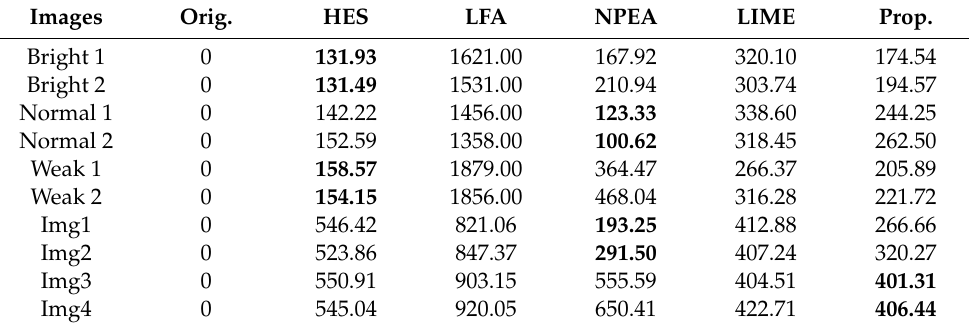
Table 8. Quantitative measurement results of LOE.